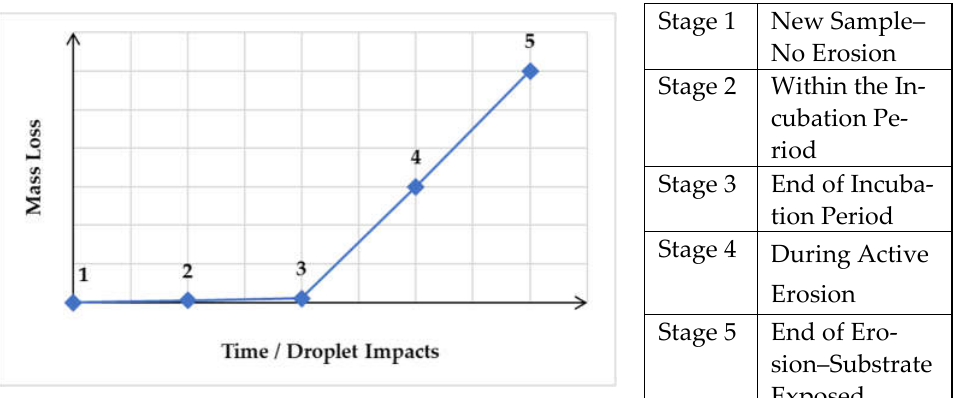
Figure 5. Erosion stages outlined on a mass versus test time/droplet impacts plot.